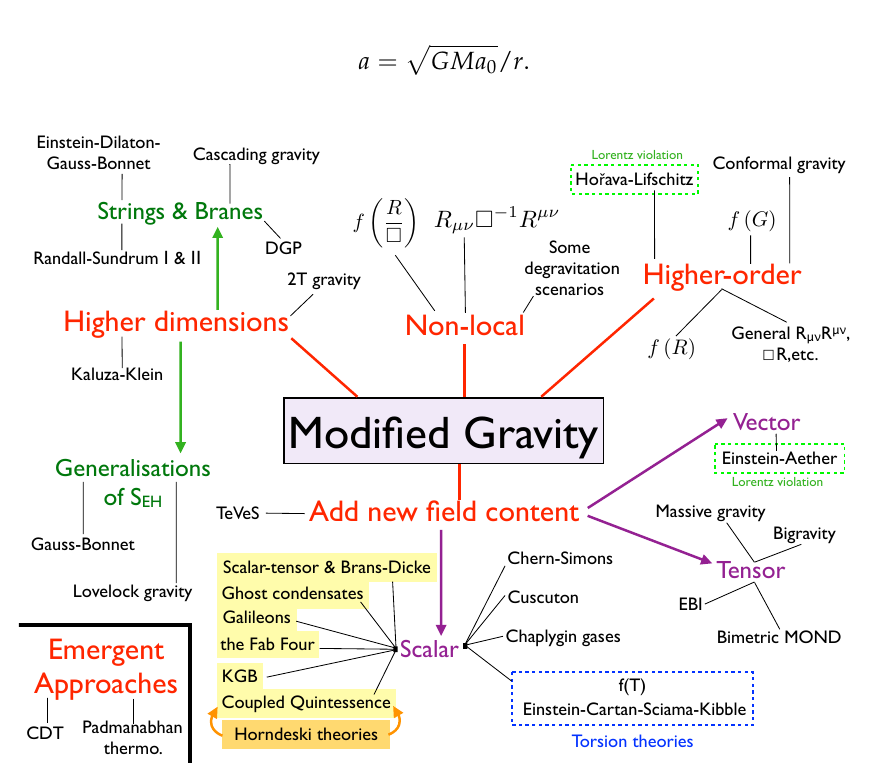
Figure 11. MGs tree diagram, reproduced from [358] (with permission from Tessa Baker). For a test particle in circular motion around the galactic centre, for small acceleration, far away from the centre, √ GMa 0 and one re-obtains the baryonic Tully-Fisher the rotation velocity reaches a plateau V f = 4 = Ga relation V 4 0 M b f